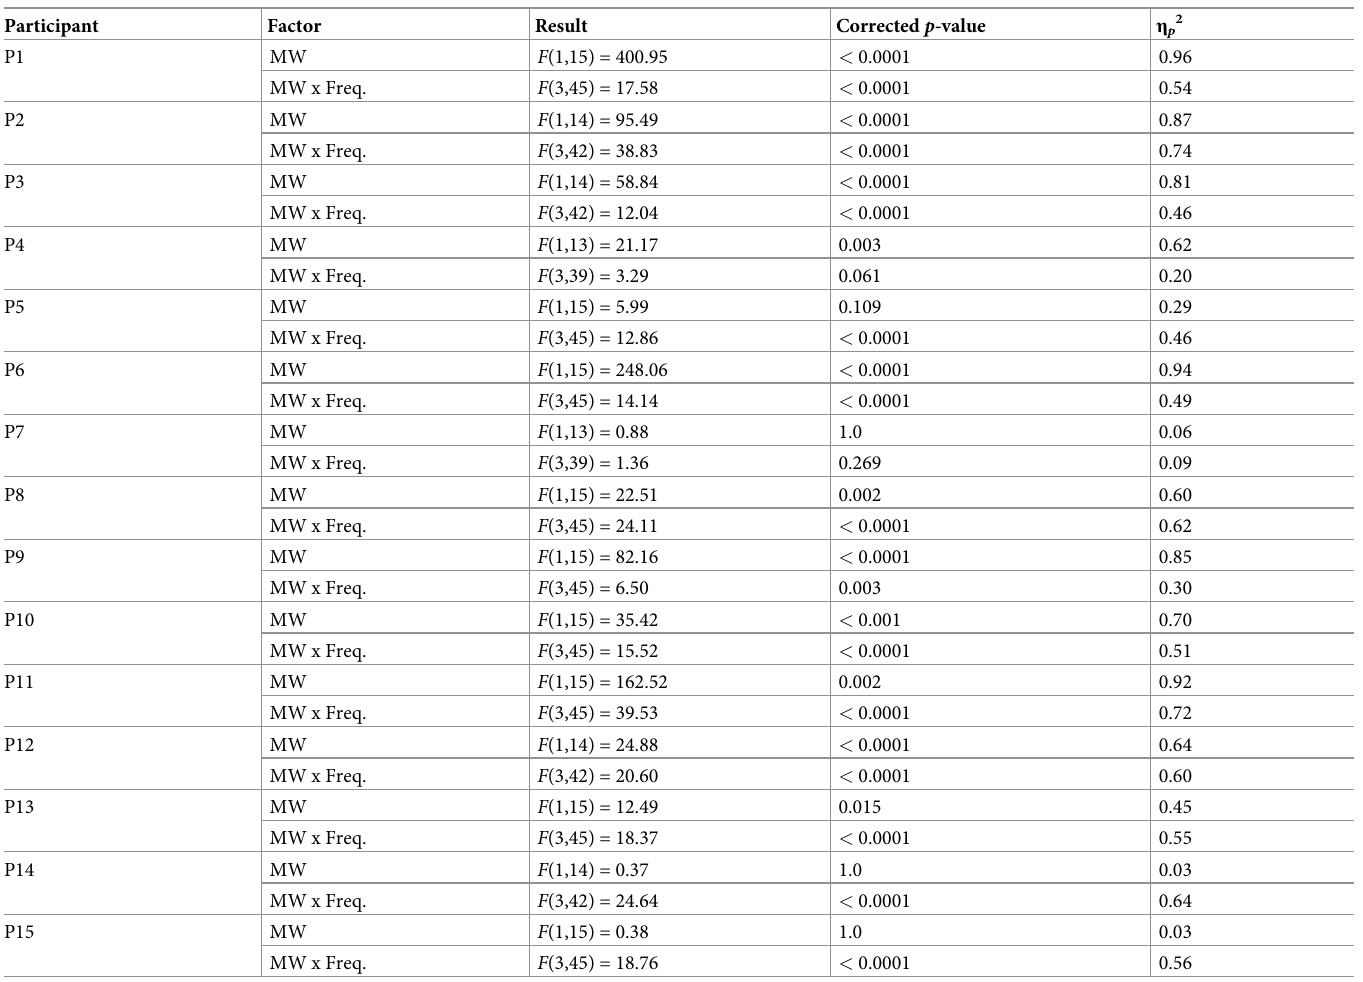
Table 5. Results of repeated-measures ANOVA models for each participant.